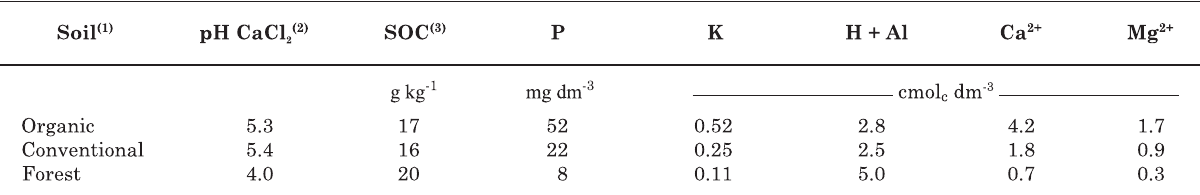
Table 1. Soil chemical characteristics in the vineyards under organic and conventional management and an adjacent forest